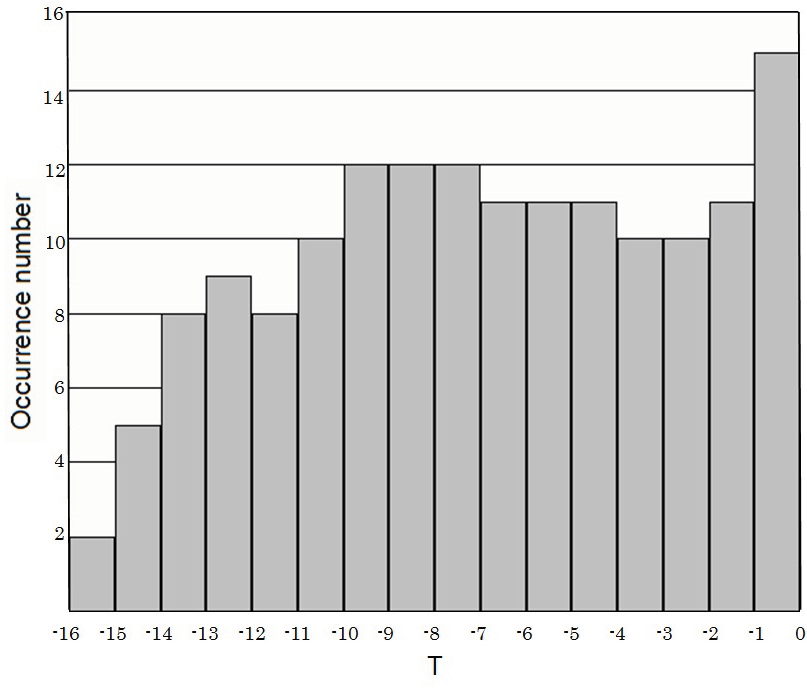
Figure 5. Occurrence histogram of pre-EQ extremely-low-frequency (ELF) radio emissions. Reproduced from a figure in Hata et al. (2006) [32] (with permission of the publisher) in which we define that strong emissions have a weight of unity and weak emissions have the weight of 0.5 (T in